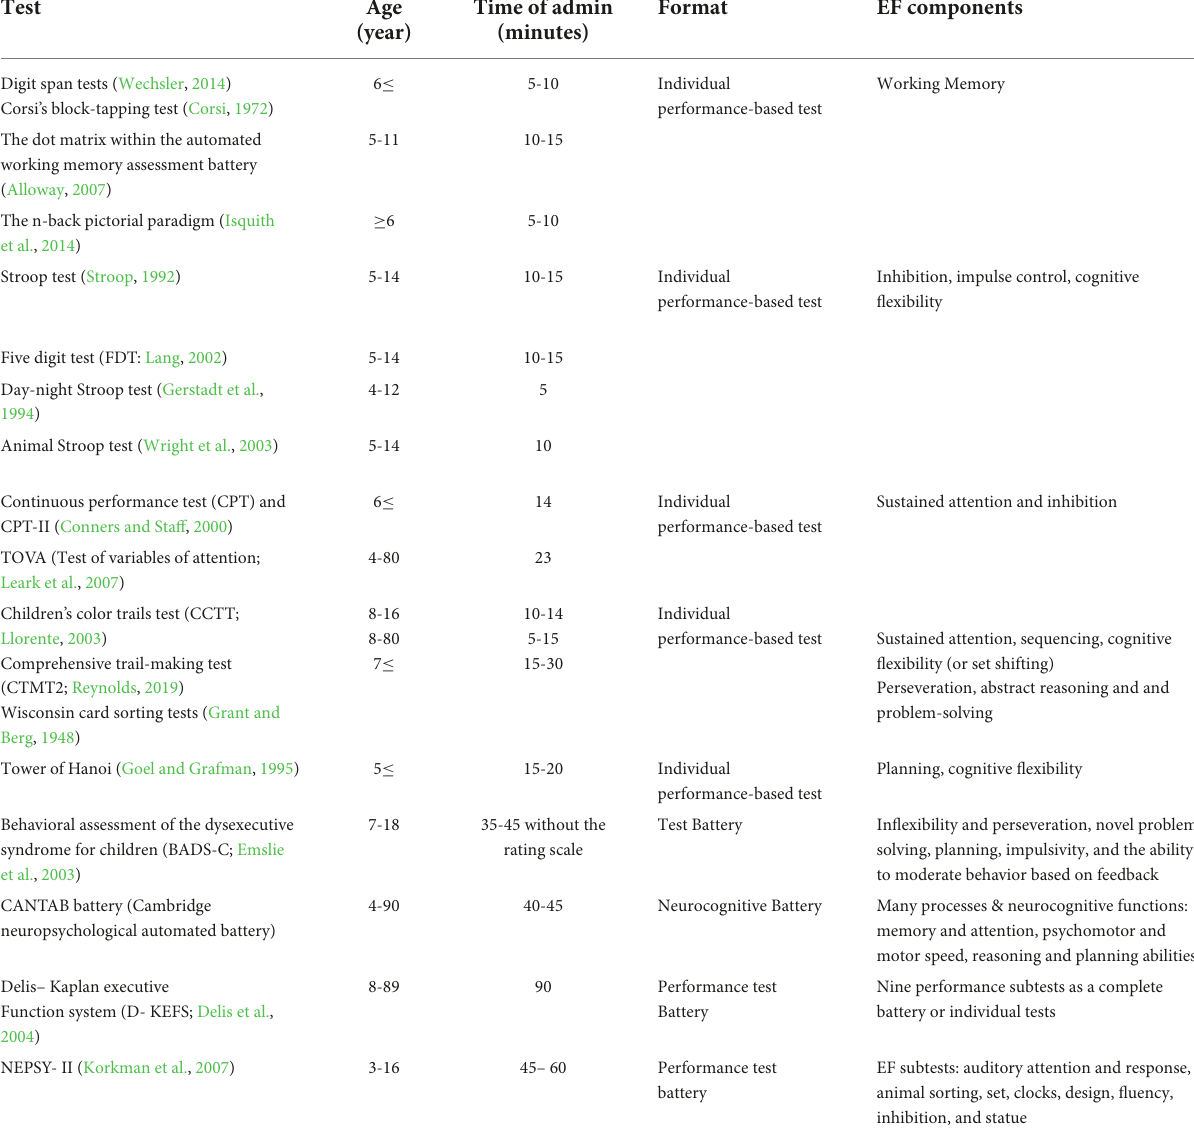
TABLE 1 Performance-based tests assessing executive functions ( EF) in school-aged children. Test Age